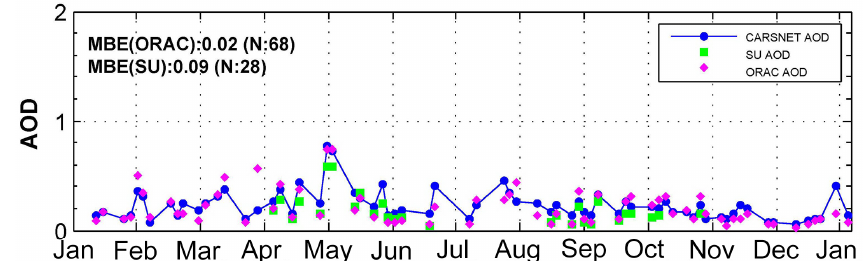
Figure 11. Time series comparison of AATSR AOD with CARSNET AOD at Ejina in